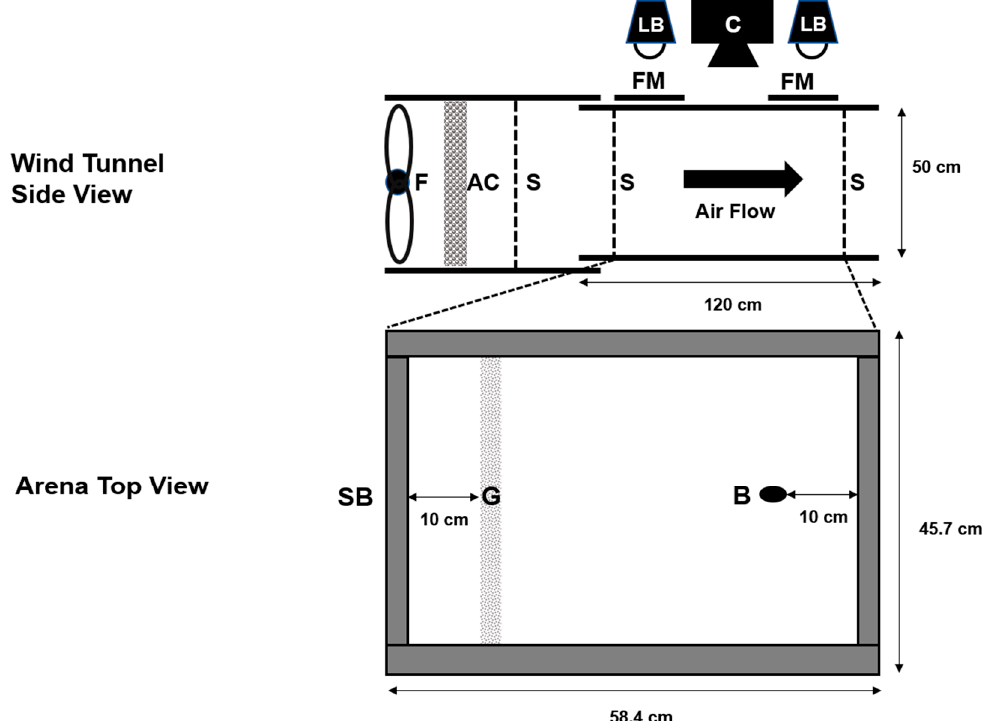
Figure 1. Wind tunnel arena. Tunnel was constructed using 4-mm-thick Plexiglass. Corrugated plastic framed screens (S) were used to section off the middle to form an arena, the base of which was lined with brown dry sheathing paper, which was held down by 2-cm-wide, 3-mm-thick steel bars (SB) on all four sides. A band of blank or pheromone granules (G) were introduced 10 cm from the upwind end of the arena, and test beetles (B) were placed 10 cm from the downwind end of the tunnel at the start of trials. The tunnel was illuminated with two 23-W compact fluorescent lamp blubs (Daylight Mini Twister, Philips Lighting, Markham, ON, Canada) located on both sides of the arena (LB), which were diffused with a layer of foam (FM). At one end of the tunnel, a 52 cm × 52 cm box fan (F) was used to drive wind through activated charcoal (AC).